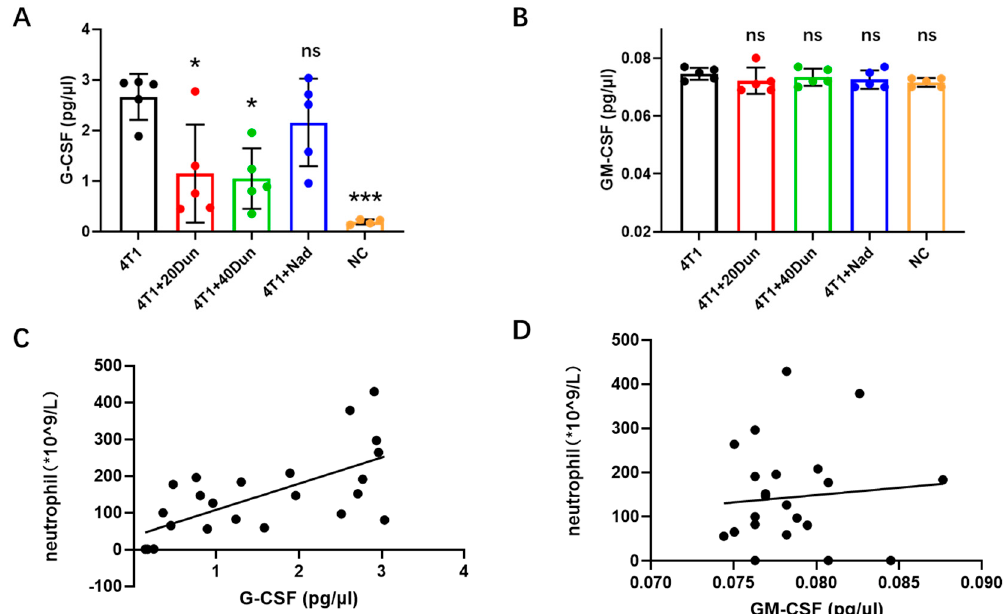
Figure 3. Dunnione reduces the peripheral neutrophil counts in tumor − bearing mice by modulating the granulocyte colony − stimulating factor (G − CSF) rather than the granulocyte − macrophage colony − stimulating factor (GM − CSF). ( A , B ) Systemic levels of G − CSF ( A ) and GM − CSF ( B ) were assessed by specific enzyme − linked immunosorbent assay (ELISA) kits following the manufacturer’s instructions ( n = 5 per group). ( C , D ) Correlation of neutrophil counts to the plasma G − CSF levels ( C ) and GM − CSF levels ( D ) ( n = 24). p − values were obtained by one-way ANOVA. Data represent mean the ± SD. Significances as compared to the samples of the 4T1 group. ns, not significant; * p < 0.05; *** p < 0.001.